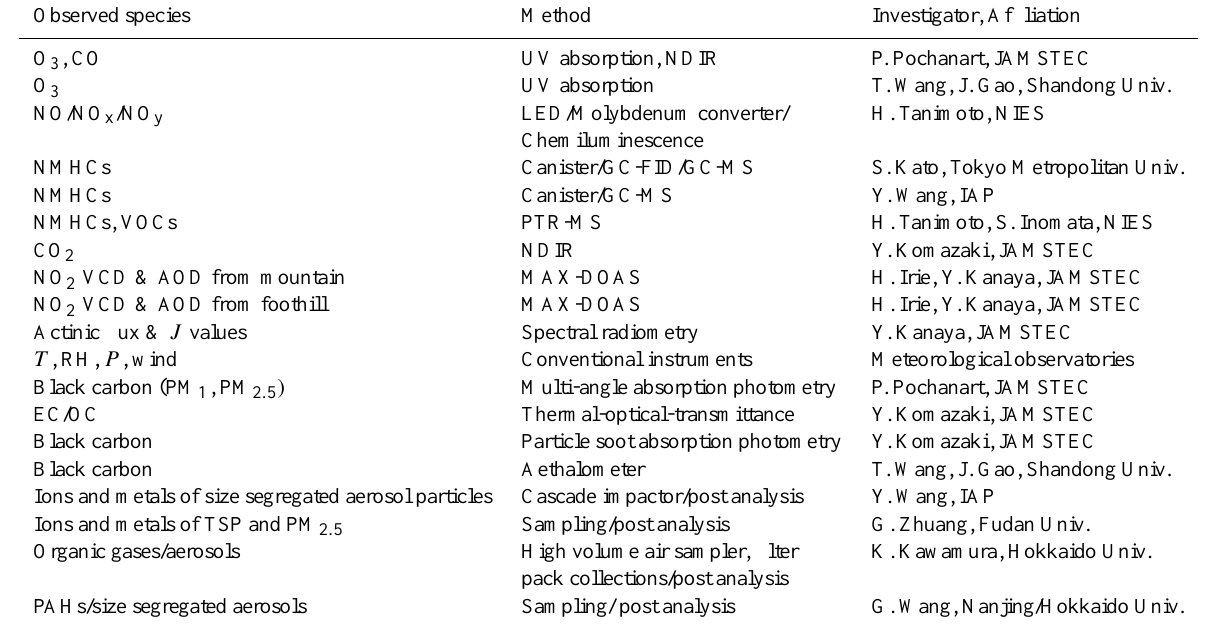
Table 1. Observed species and methods, and investigators responsible for observations. Observed